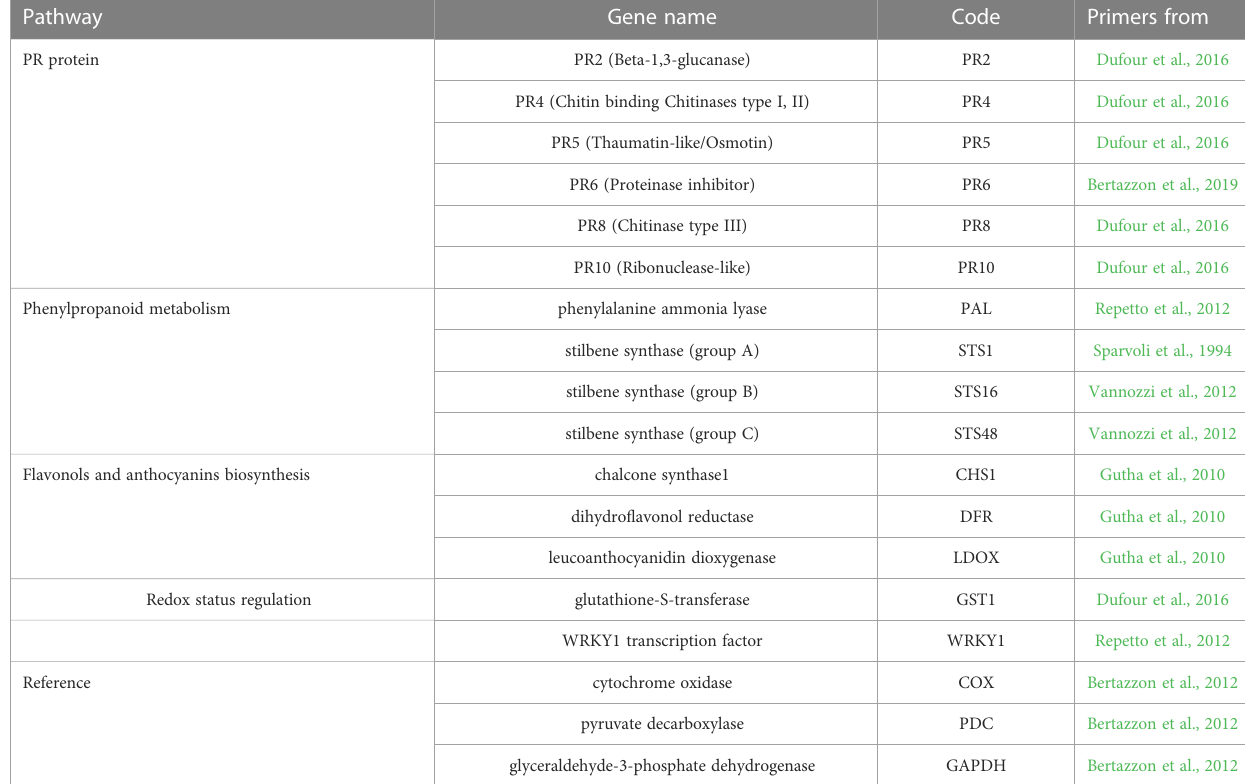
TABLE 1 Defense and stress-related genes studied.